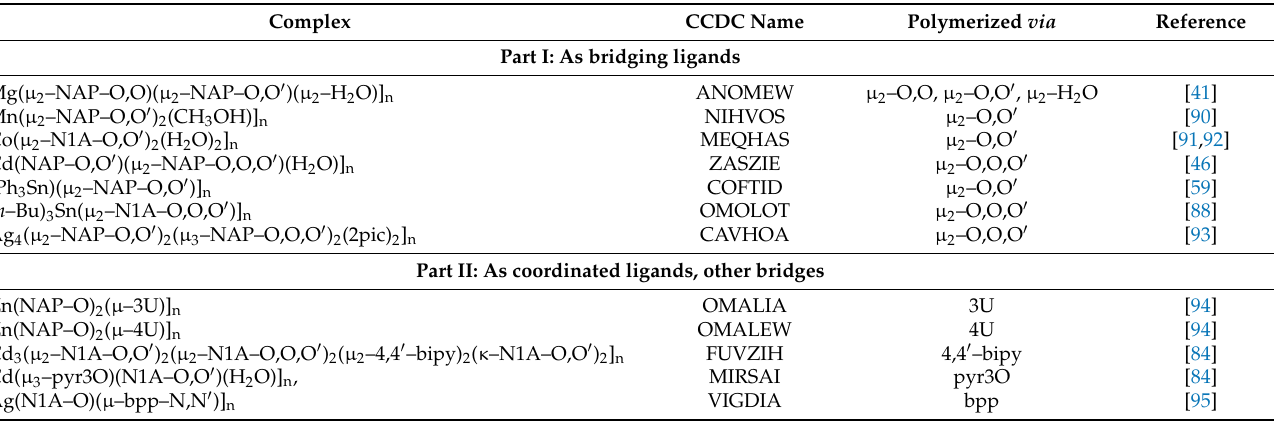
Table 4. Polymeric complexes of 1–naphthylacetato and naproxen ligands. Coordination mode of the ligands, CCDC name of the complex and polymerization linkers.